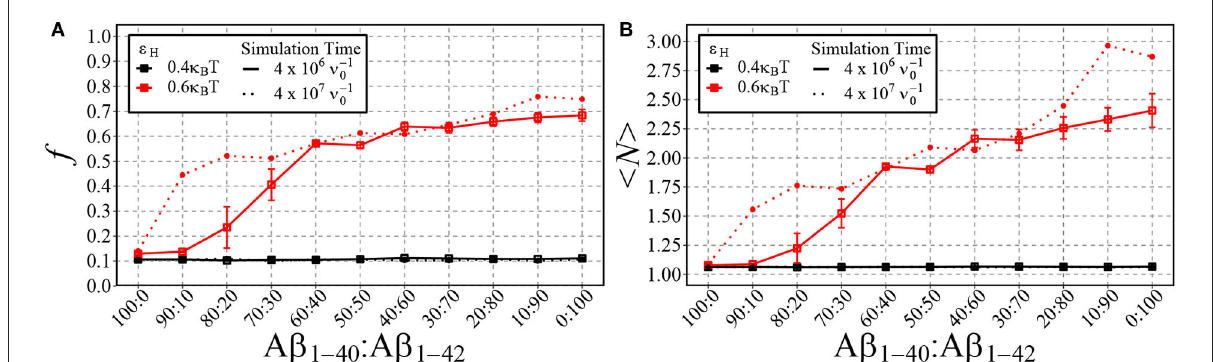
FIGURE8 Shown are the fraction of aggregated material, f , (A) and the mean cluster size, different values of ε H . 100 total chains were used in each simulation. A consistent box size of 80 all simulations, with ε e represents the mean and standard error of 3 simulations. For longer simulation times (4 single simulation.